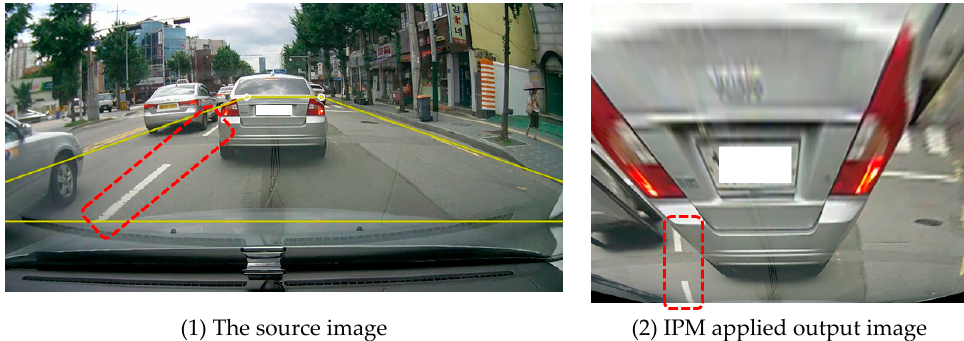
Figure 3. Removal of the perspective effect by IPM.